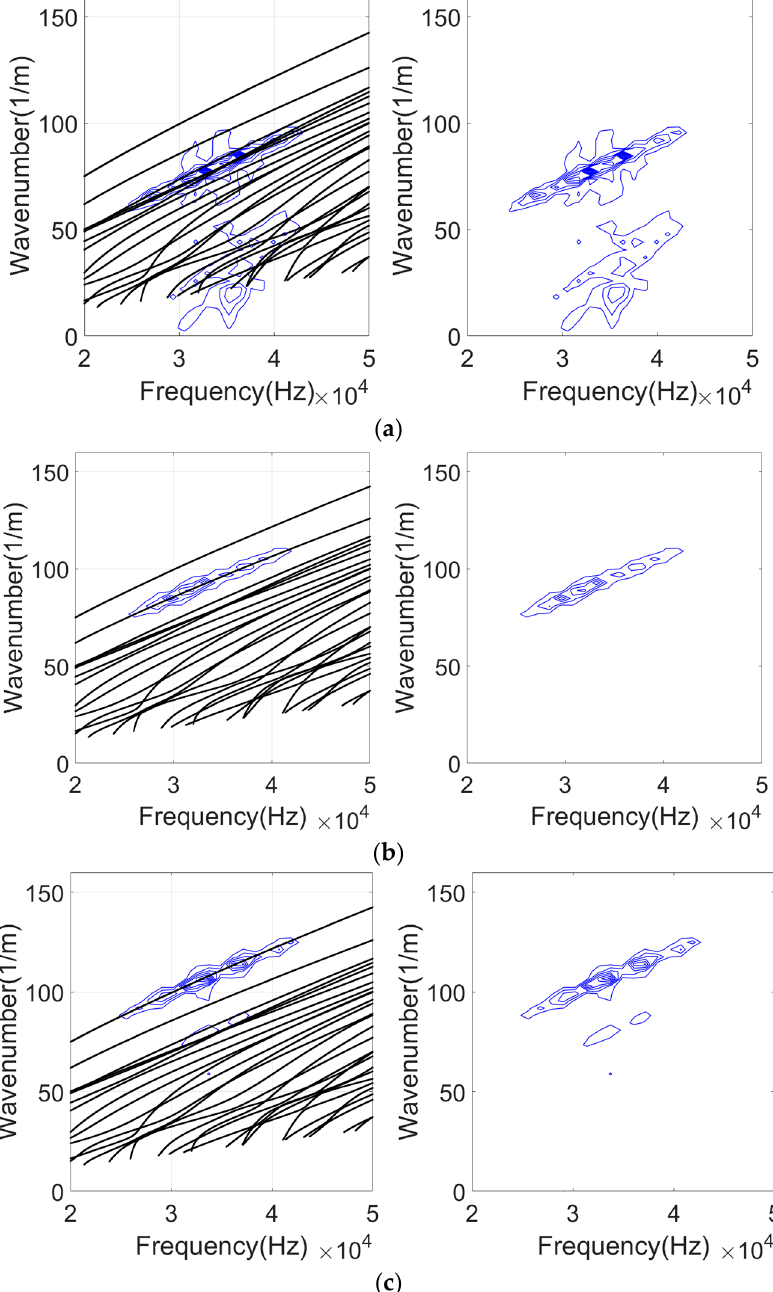
Figure 14. Frequency wavenumber curves. ( a ) mode 1 defect reflected echo 2D-FFT results; ( b ) mode 3 defect reflected echo 2D-FFT results; ( c ) mode 7 defect reflected echo 2D-FFT results.